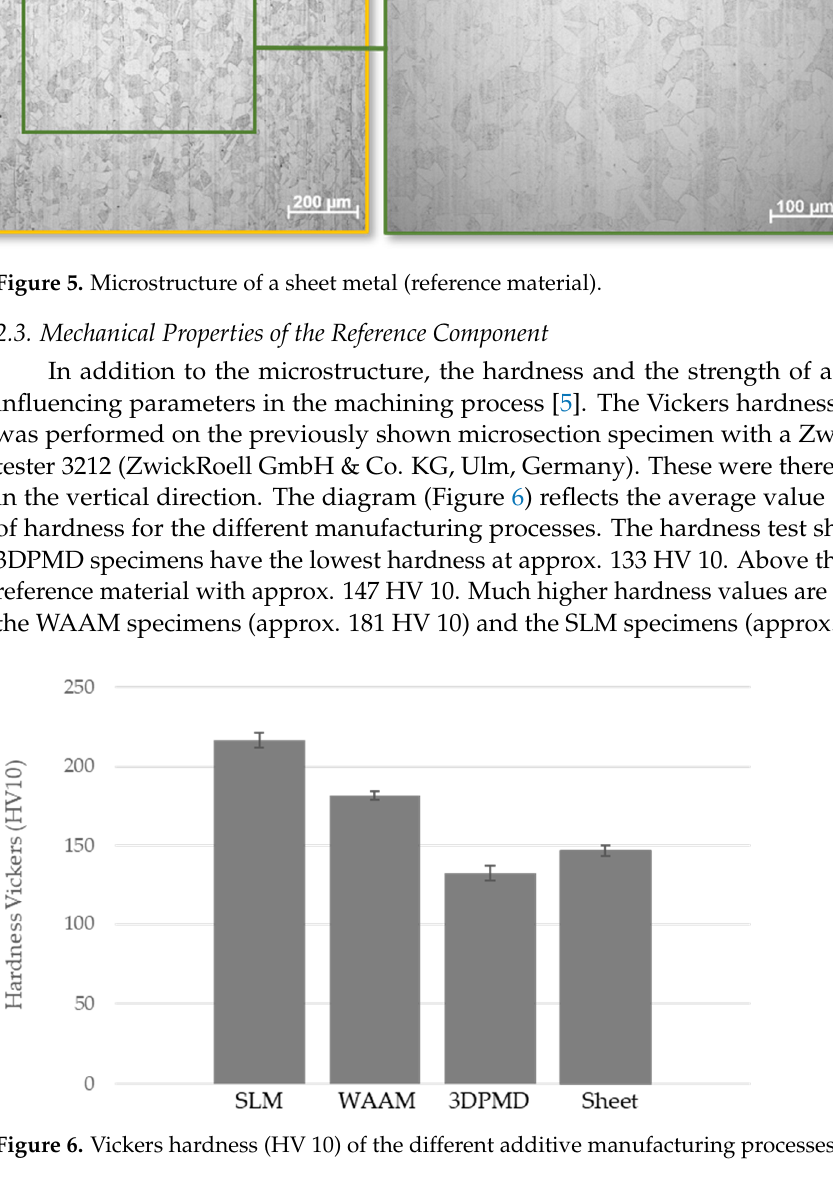
Figure 6. Vickers hardness (HV 10) of the different additive manufacturing processes.